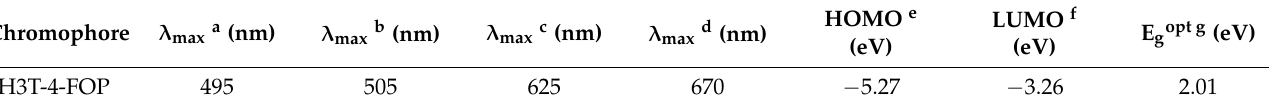
Figure 2. ( a ) UV-Vis absorption and ( b ) photoluminescence spectra of H3T-4-FOP SOM in chloroform solvent and in thin film. Table 1. Optical and electrochemical values of H3T-4-FOP SOM.